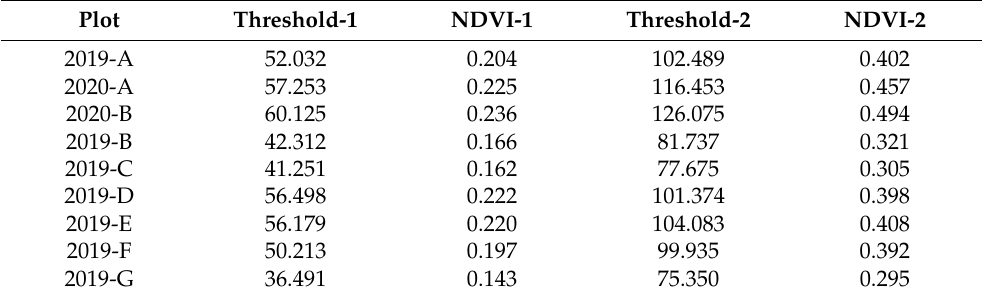
Table 4. Table of the optimal threshold distribution obtained by GWO-OTSU double-threshold segmentation for each